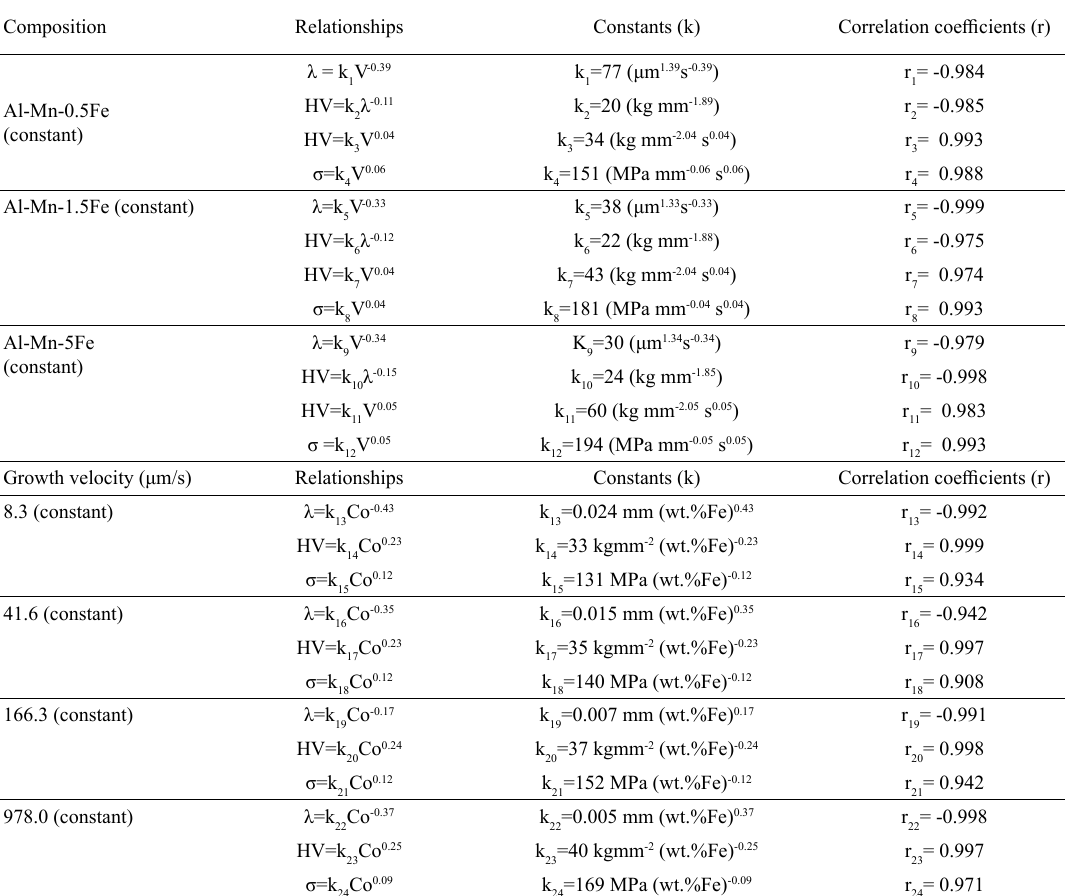
, C , and λ for Al–1.9Mn–xFe U o